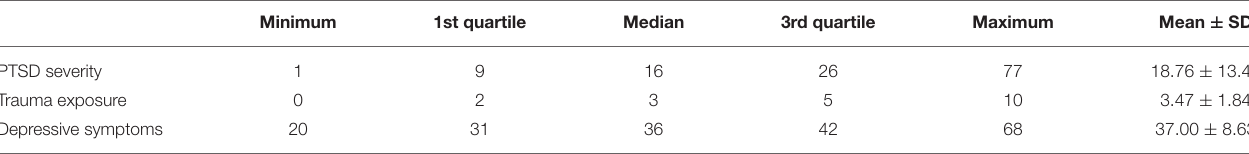
TABLE 1 | Summary of posttraumatic stress disorder (PTSD) severity (total symptoms), trauma exposure, and depressive symptom scores.